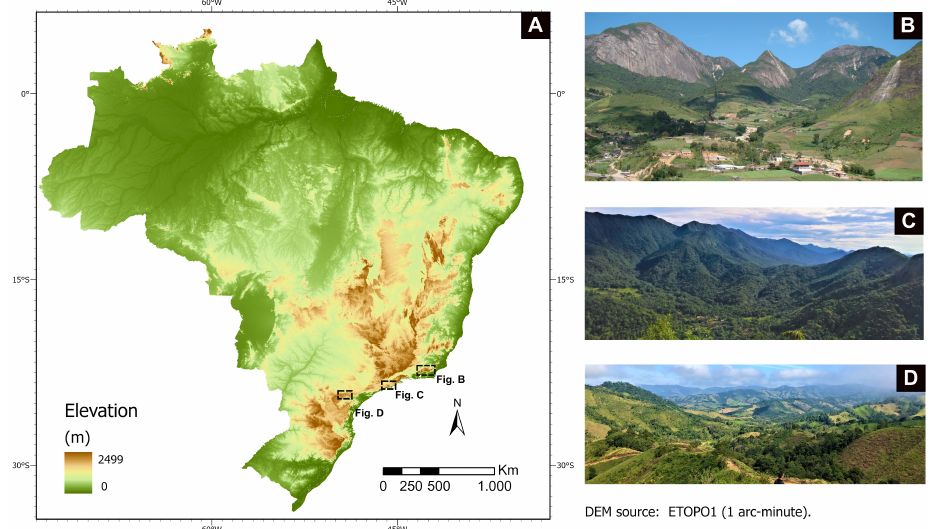
Figure 1. Geomorphological characteristics of Brazil and examples of mountain regions. ( A ) Elevation of Brazil. ( B ) Rio de Janeiro mountain range (Source: Marcelo F. Gramani); ( C ) Serra do Mar in Caraguatatuba, São Paulo; ( D ) Serra do Mar in Itaóca, São Paulo (source: Vivian